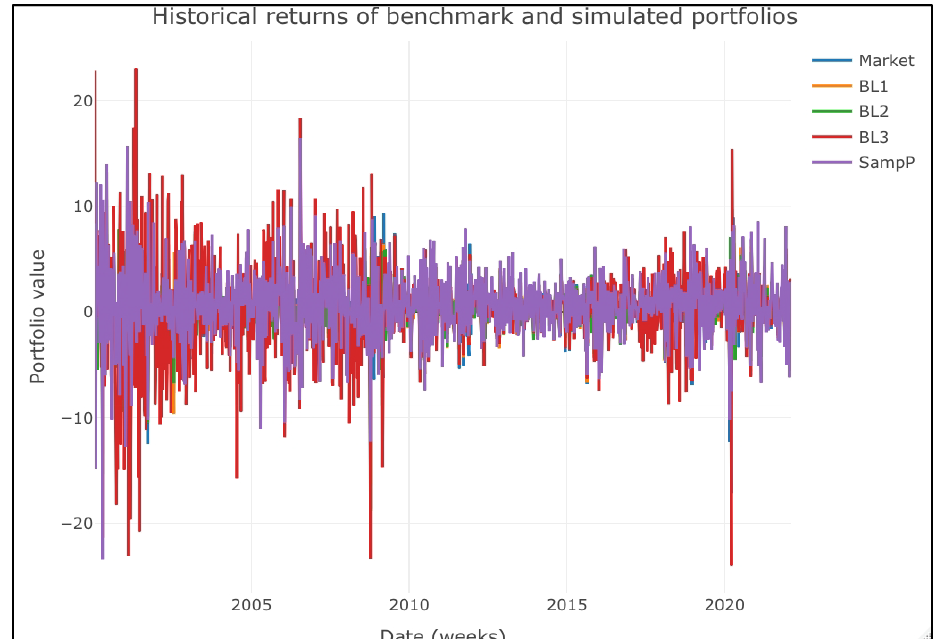
Figure 2. Historical percentage variations of the simulated portfolios.